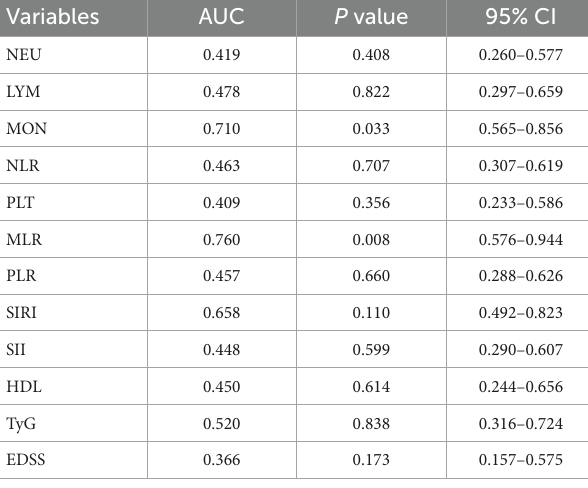
TABLE 2 Spearman’s correlation analysis between hemocyte indexes and EDSS.